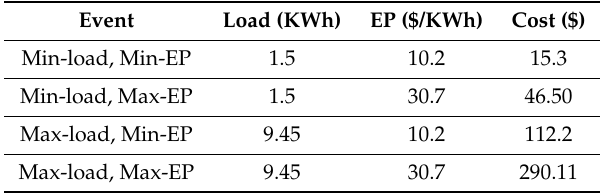
Table 6. Cost results against various load and price profiles considering